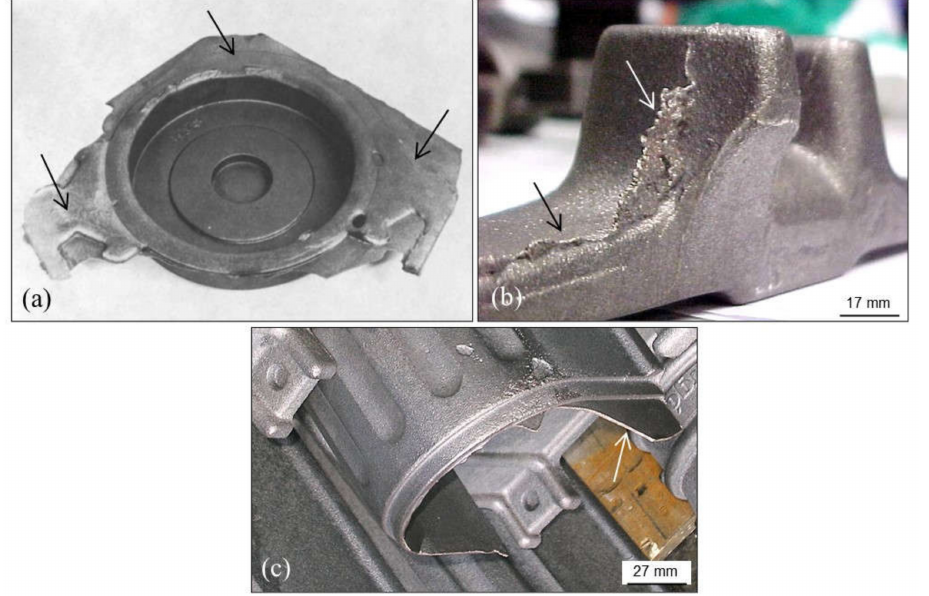
Figure 48. ( a ) Mold lifting in a brake drum of malleable iron (Reprinted with permission from ref. [17]. Copyright 1999 American Foundry Society, page 55). Burrs originated in ductile iron casting ( b ) and in grey iron casting ( c ) due to mold separation (vertical molding lines).